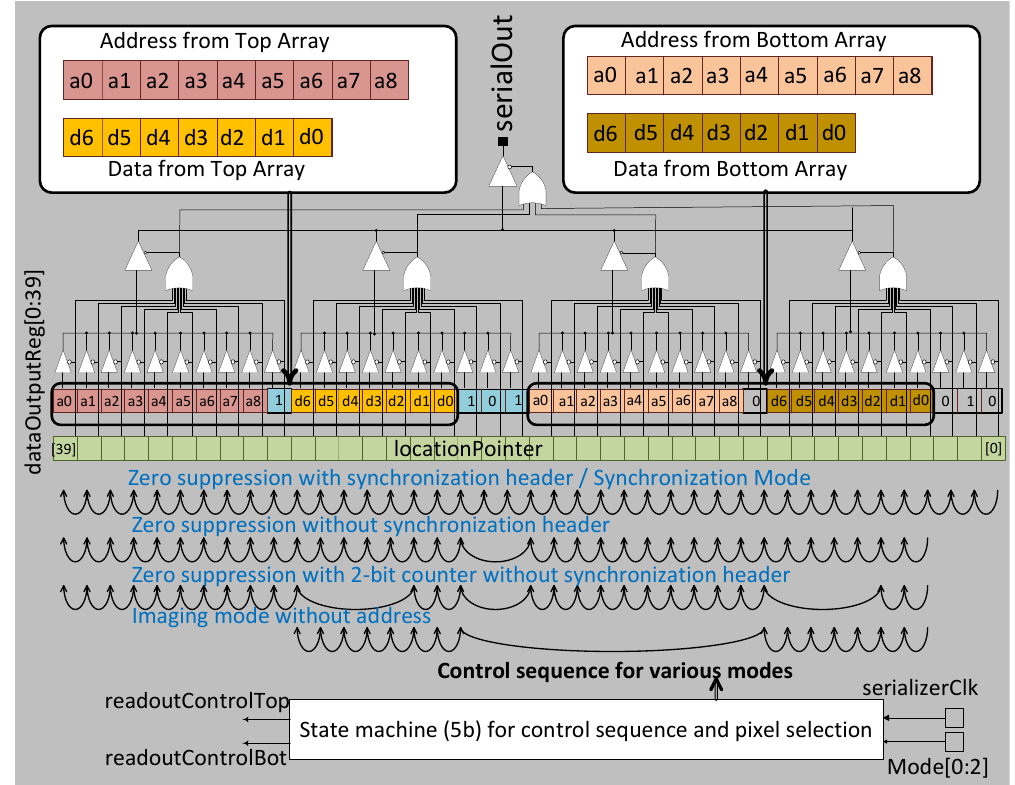
Figure 7. The output serializer consists of a 40-bit dataOutput register where the two top and bottom banks have their own independent 20-bit output registers The 40-bit locationPointer register with a single ‘1’ in its bit stream enables the tristate buffer allowing the corresponding dataOutput register bit to be sent off-chip. The locationPointer sequence is shown at the bottom for different operating